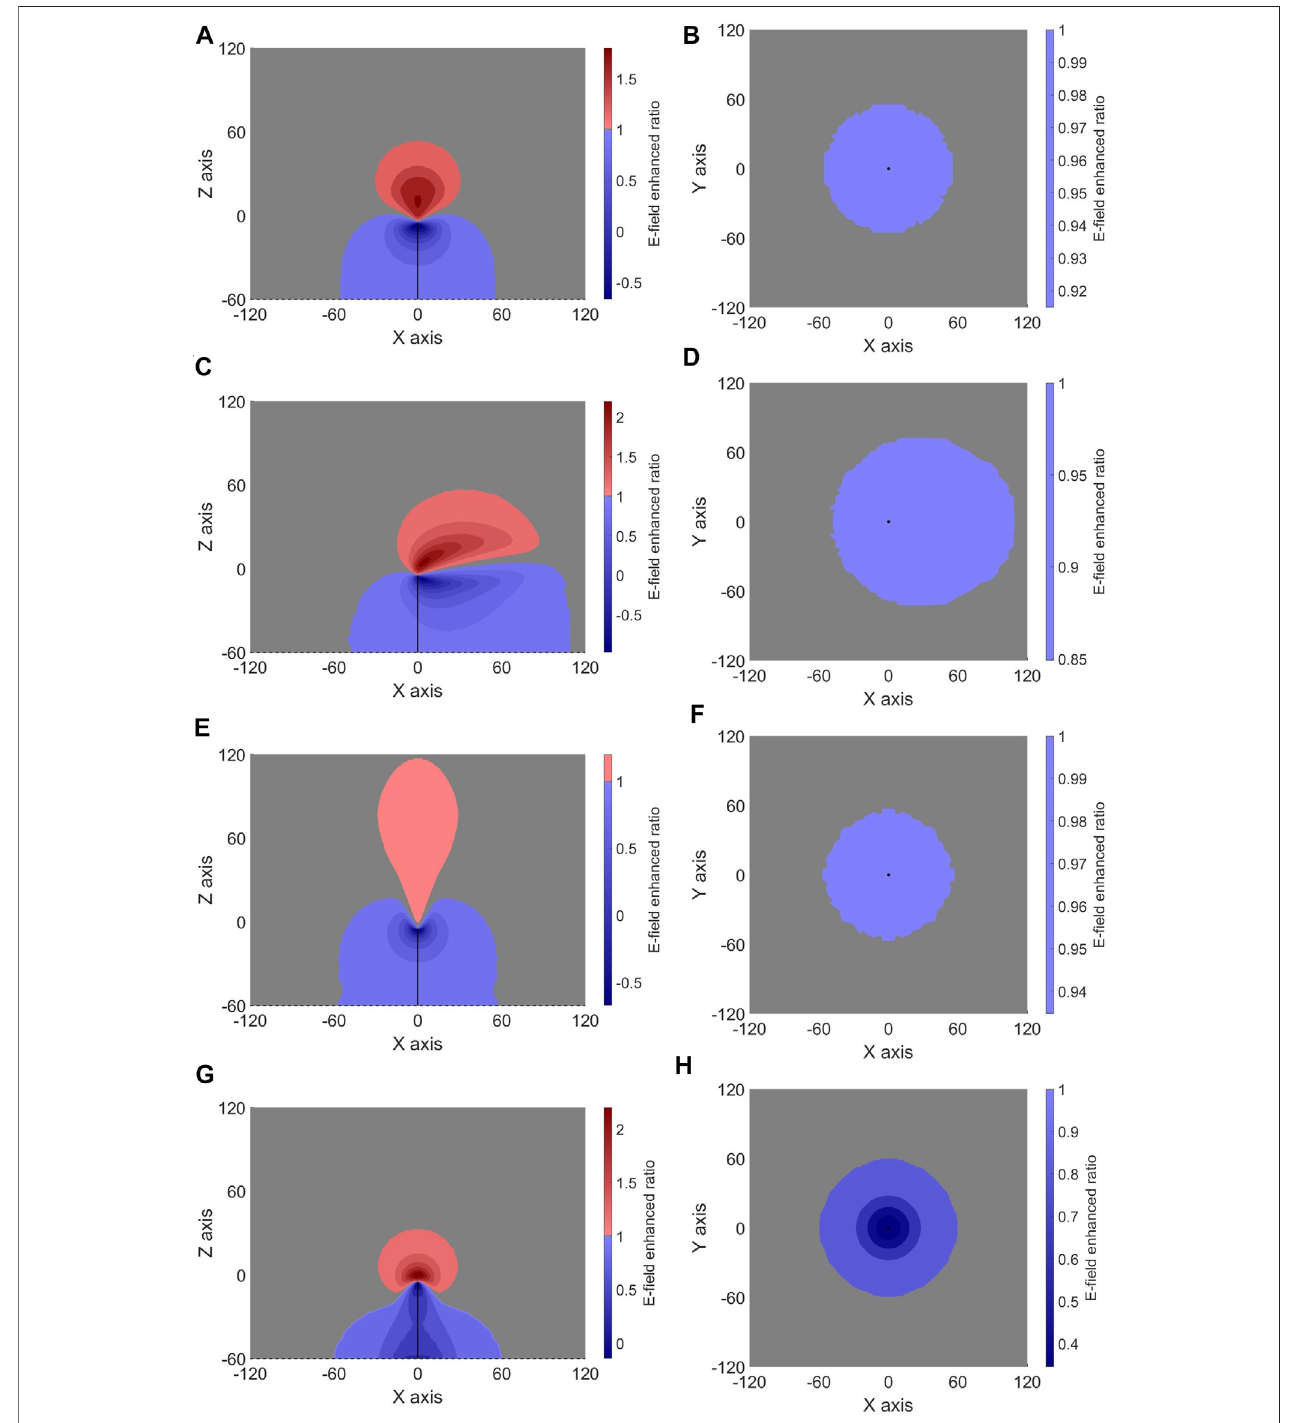
FIGURE 7 | Contours of distortion caused by corona charges in the E- fi eld (N) around the building tip when the thunderstorm background E- fi eld reached its maximum value (20 kV/m). No wind (A,B) . Horizontal wind (C,D) . Updraft (E,F) . Downdraft (G,H) . The left side shows the side views, and the right side shows the top